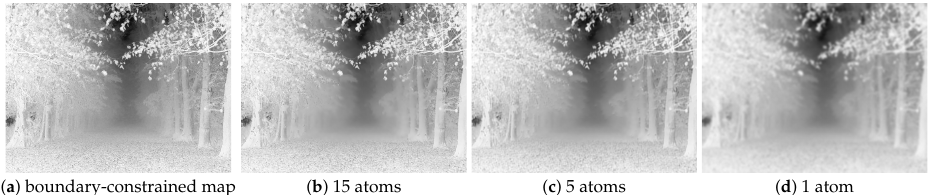
Figure 3. An illustration of smoothing a piece-wise transmission map ( a ) with 15 atoms ( b ), 5 atoms ( c ) and 1 atom ( d ),